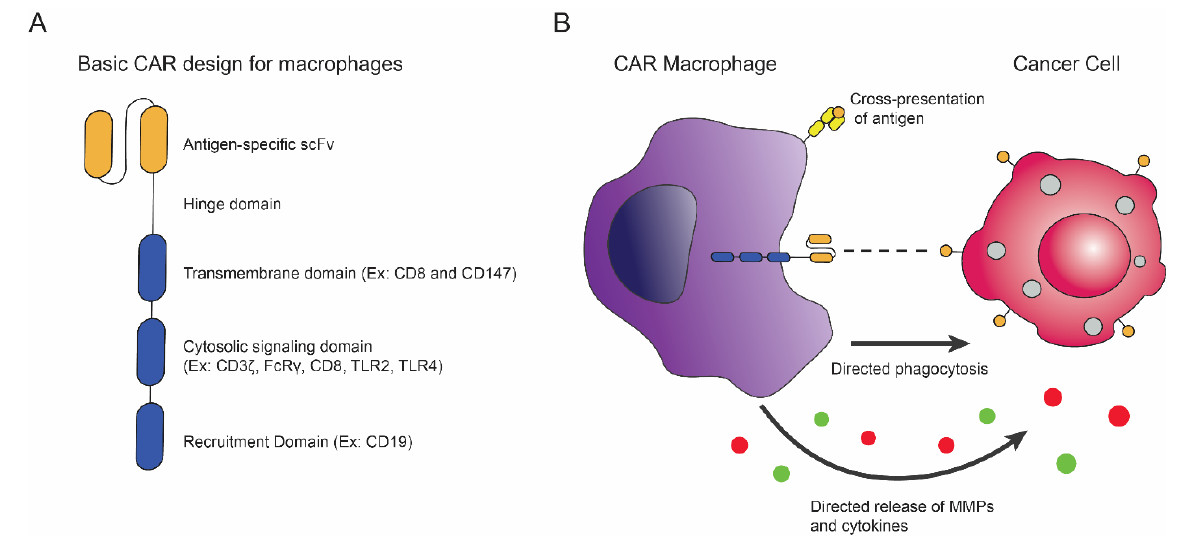
Figure 5. Basic CAR design and effector functions of CAR macrophages . ( A ) The basic CAR design for macrophages includes an antigen-specific scFv region that binds to antigen on target cells, a hinge domain, the transmembrane domain that can be derived from portions of molecules, such as CD8 and CD147 (as previously described by Morrissey et al, Klichinsky et al., and Zhang et al.), a cytosolic signaling domain that promotes phagocytosis or the release of MMPs and cytokines depending on the domain used, and an optional recruitment domain to enhance signaling (such as CD19, Morrissey et al.). ( B ) The anti-tumor functions of macrophages can be directed towards cancer cells, including phagocytosis and the release of inflammatory cytokines and metalloproteinases (MMP). Additionally, CAR-Ms can promote the activation of cytotoxic T cells by cross-presenting tumor associated or tumor specific antigens.